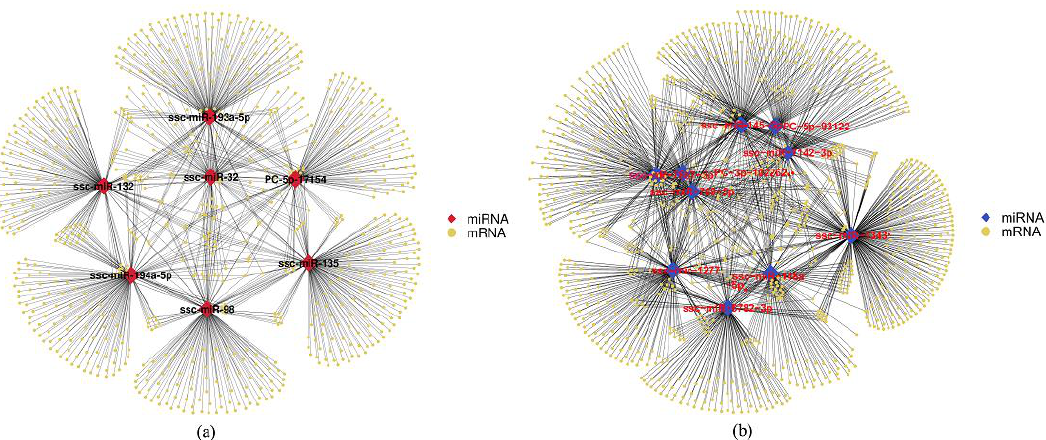
Figure 4. Target genes of the DEmiRNAs. ( a ) Interaction network of the upregulated DEmiRNA target genes. ( b ) Interaction network of the downregulated DEmiRNA target genes. Red blocks in the center indicate upregulated DEmiRNAs. In contrast, blue blocks indicate downregulated DEmiRNAs. Yellow blocks indicate mRNAs.